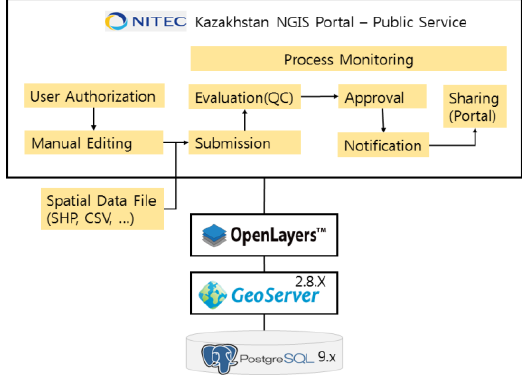
Figure 4. Kazakhstan NGIS Portal Architecture